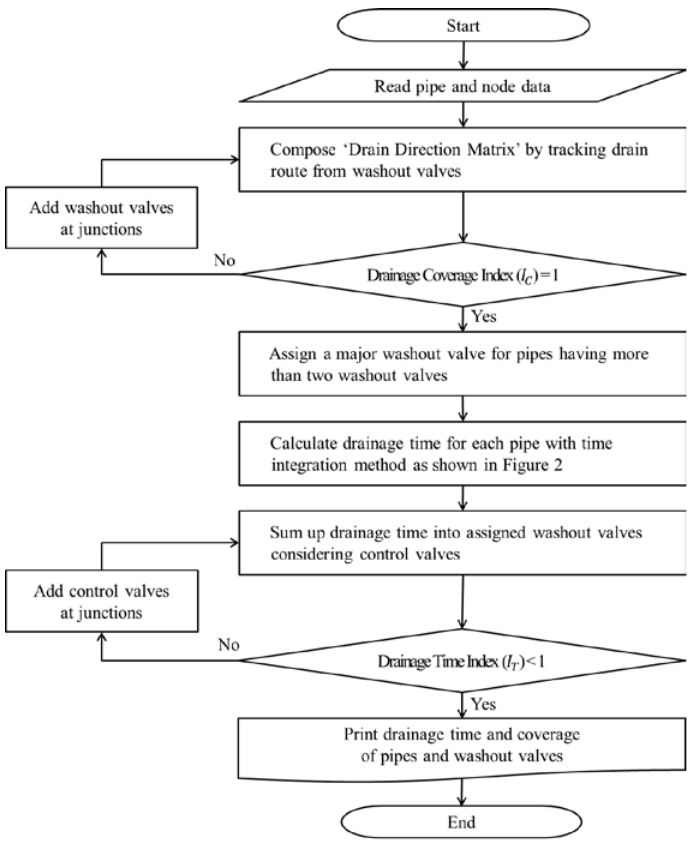
Figure 4. Proposed procedure for the valve location method.